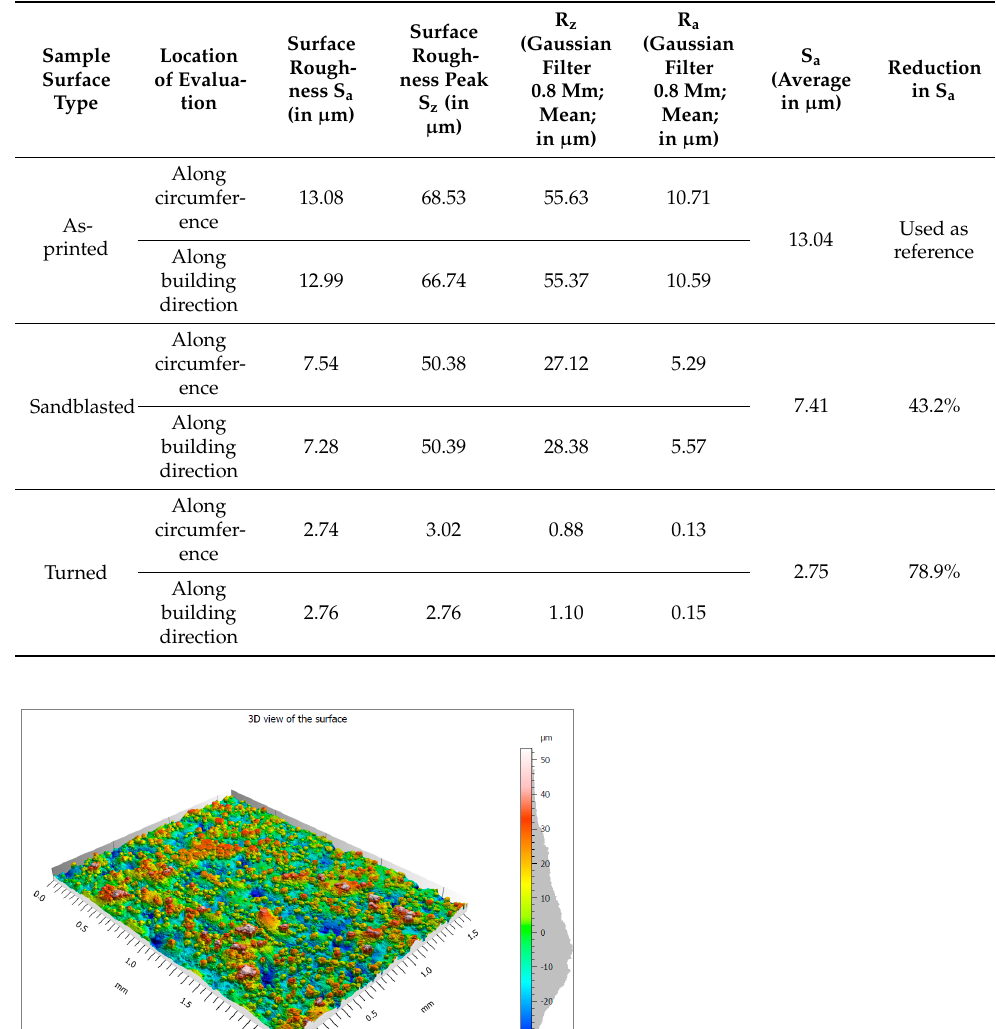
Table 4. Summary of surface roughness results when taken at different locations on the samples by confocal microscopy.